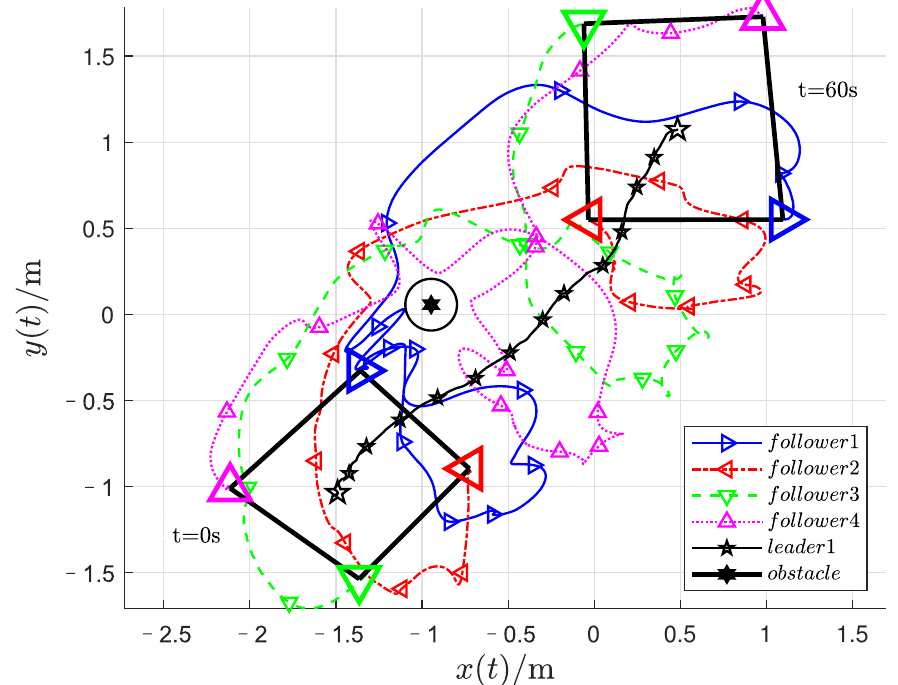
Figure 11. Position trajectories of UAVs.